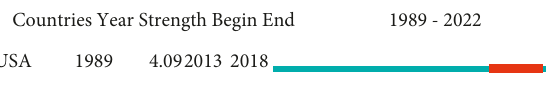
Figure 5: Top 1 countries with the strongest citation